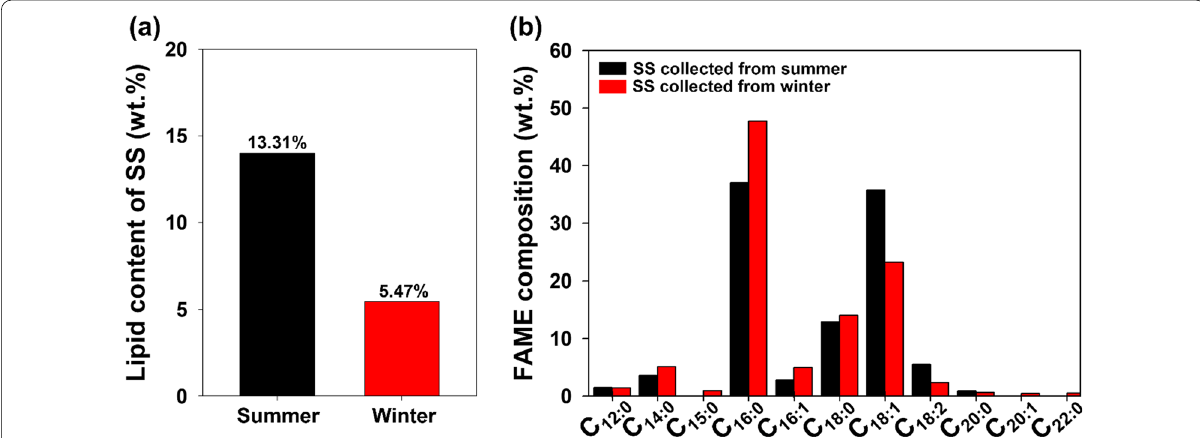
Fig. 8 a Lipid content and ( b ) FAME composition in SS collected from summer (August 2021) and winter (December 2021) in Seoul, Korea. Thermally induced transesterification of SSE was performed at 380 °C using silica to decide lipid content in